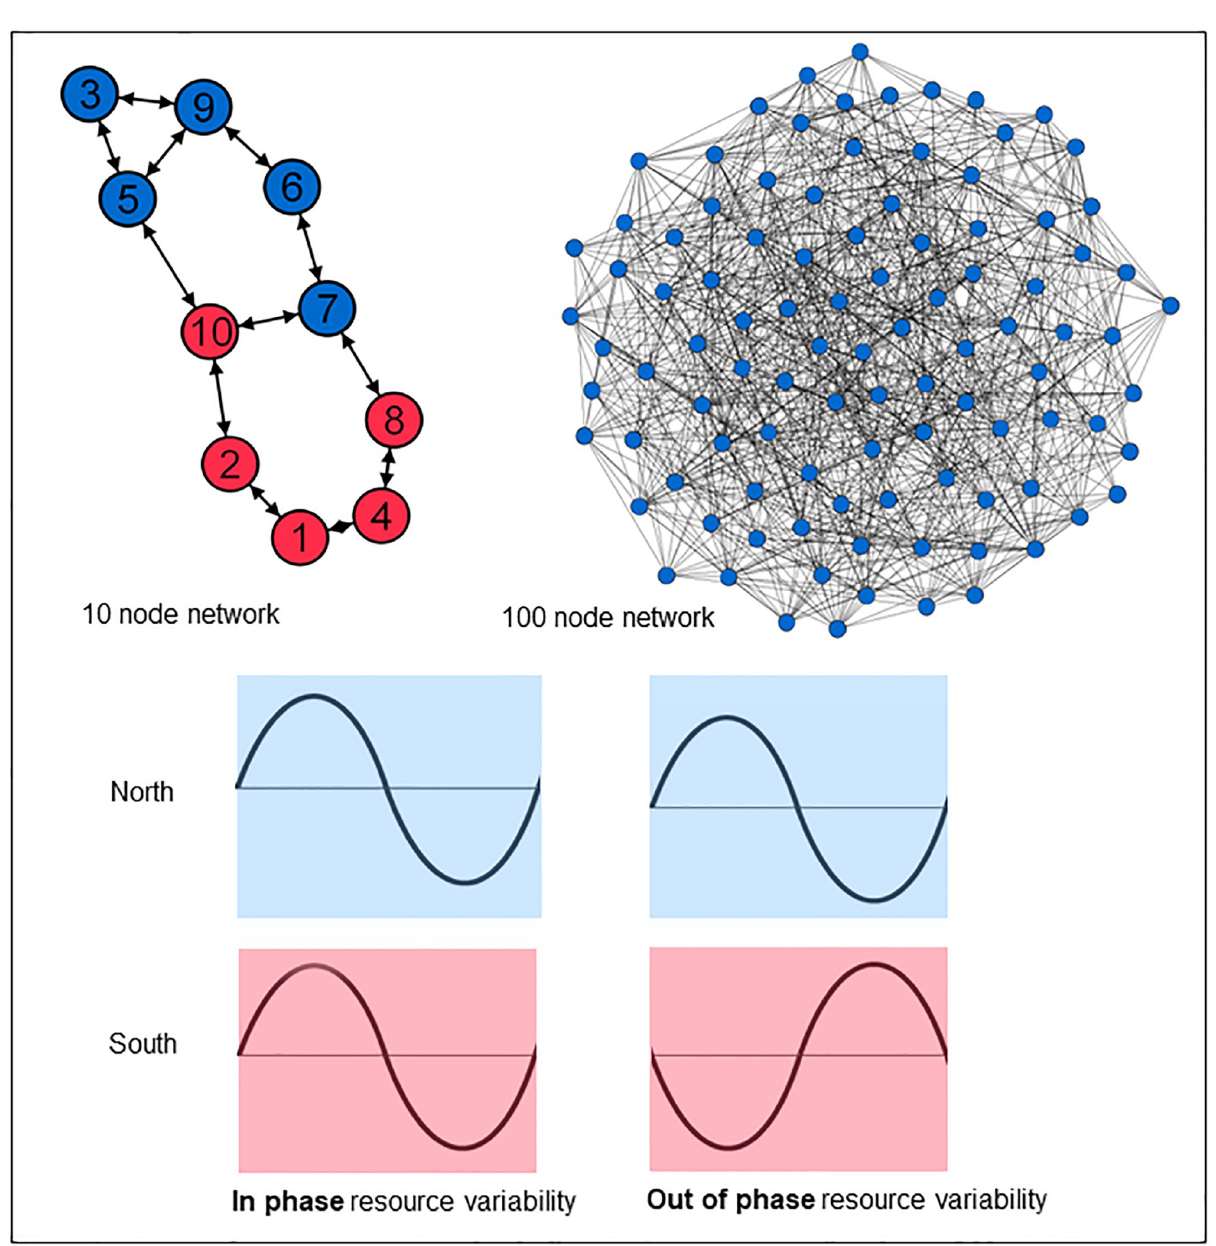
Fig 1. Conceptual overview of the networks and resource variability scenarios. The networks on which our analysis was carried out and a visualisation of the resource variability are shown. The networks are small-world and undirected, compromising 10 and 100 nodes. Resource availability at nodes varies over time in the form of a sine wave. With in phase variability, all nodes experience the same variability. In out of phase the north group (blue) experiences a sine wave 180 degrees out of phase with the south group (red), as illustrated by the colors in the 10 node network.